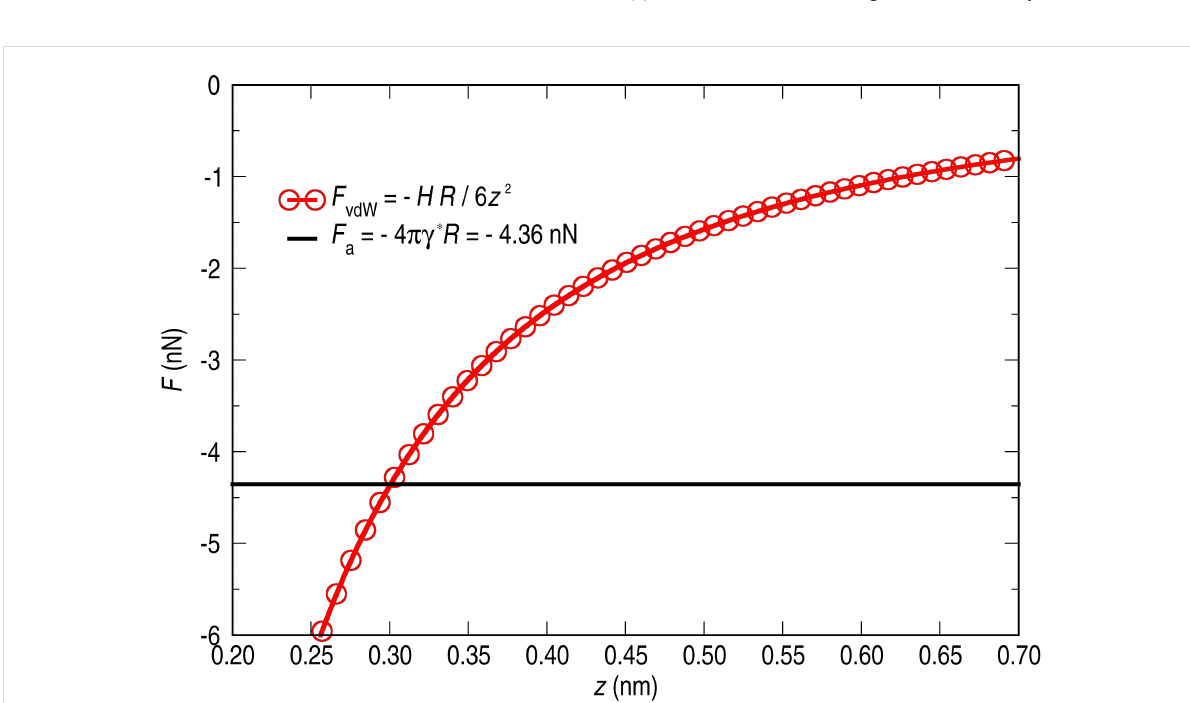
Figure 9: Forces involved in the process of picking up a Ni cluster. The tip–sample distance at which the attractive force overcomes the adhesive one is estimated to be 0.3